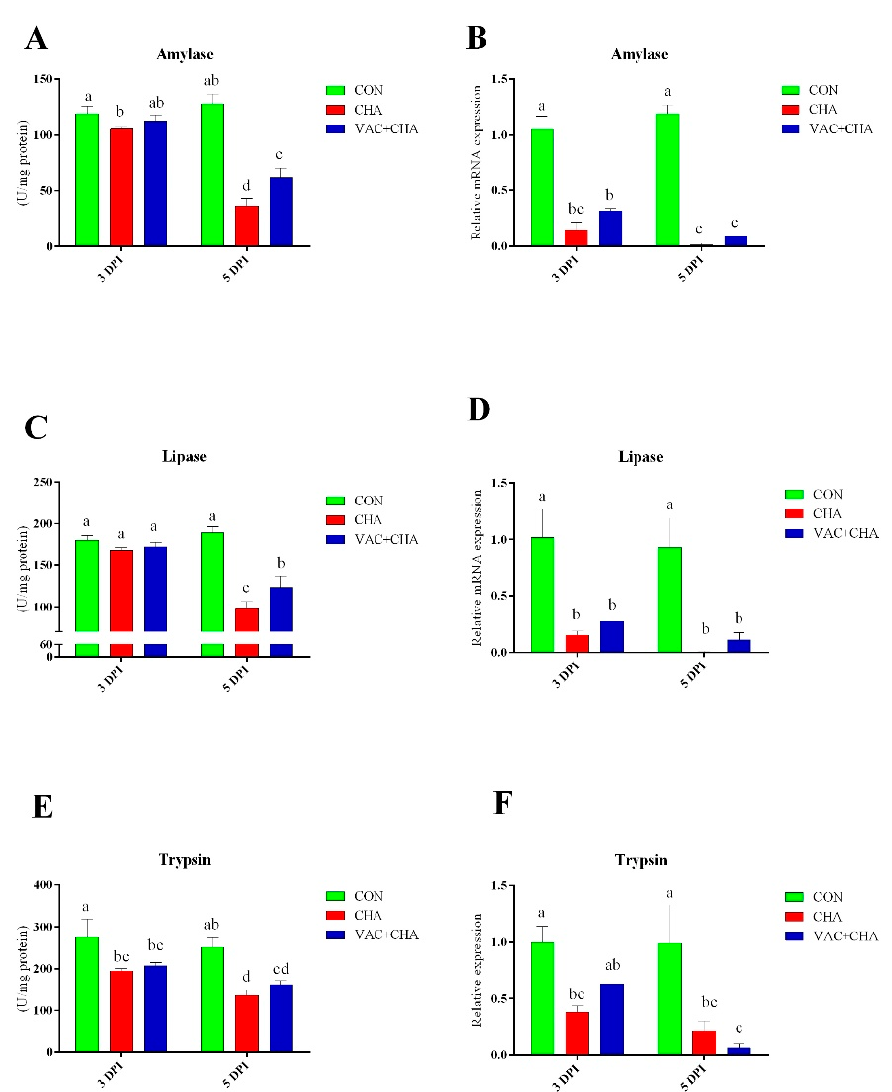
Figure 5. Mean level of activity and relative expression of the genes of pancreatic enzymes; Amylase ( A , B ), lipase ( C , D ) and trypsin ( E , F ) at 3 and 5 DPI in vaccinated and nonvaccinated chickens challenged with NDV (ZJ1). The green, red, and blue columns represent control, nonvaccinated challenged, and vaccinated challenged groups, respectively. The bars represent the standard deviation of the mean, and the lower-case letters show statistical significance ( p < 0.05) among the different groups. CON, control; CHA, Newcastle disease virus challenged; VAC + CHA, vaccinated with LaSota and challenged with virulent Newcastle diseases virus after 2 weeks of vaccination.